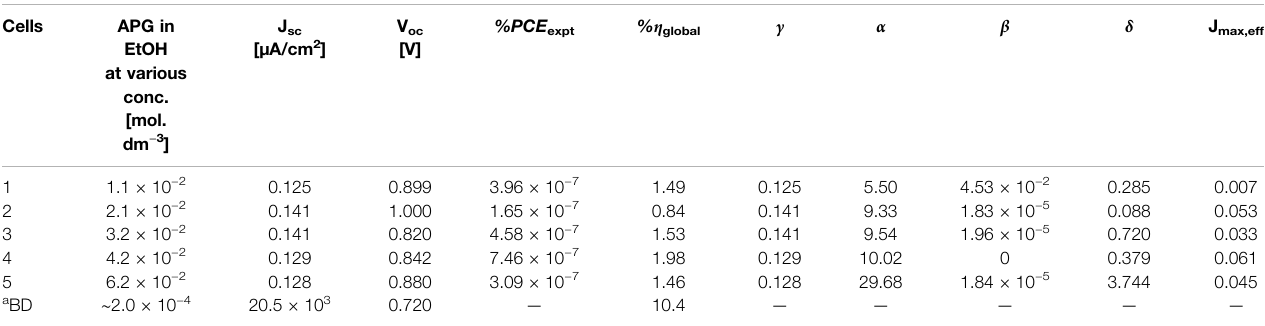
TABLE 3 | Experimental photovoltaic properties of the APG-based DSSCs at different concentrations as compared to the properties of the reported BD-based DSSC. Cells APG in EtOH at various conc.